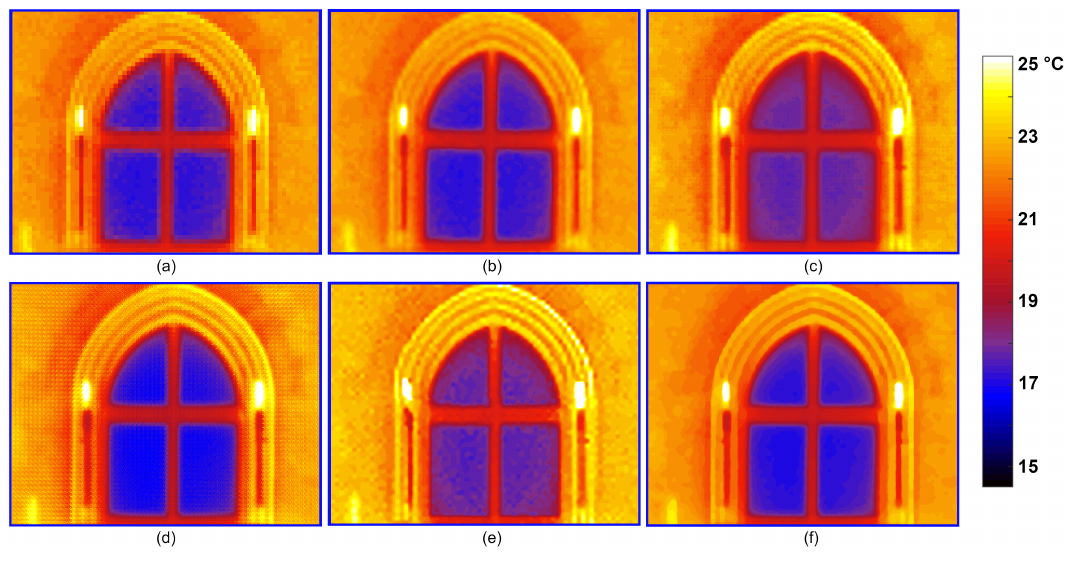
Figure 8. Window detail of the SR reconstructed images by different methods. ( a ) NN. ( b ) Bicubic. ( c ) EDSR. ( d ) RISR. ( e ) ASR2_s. ( f )